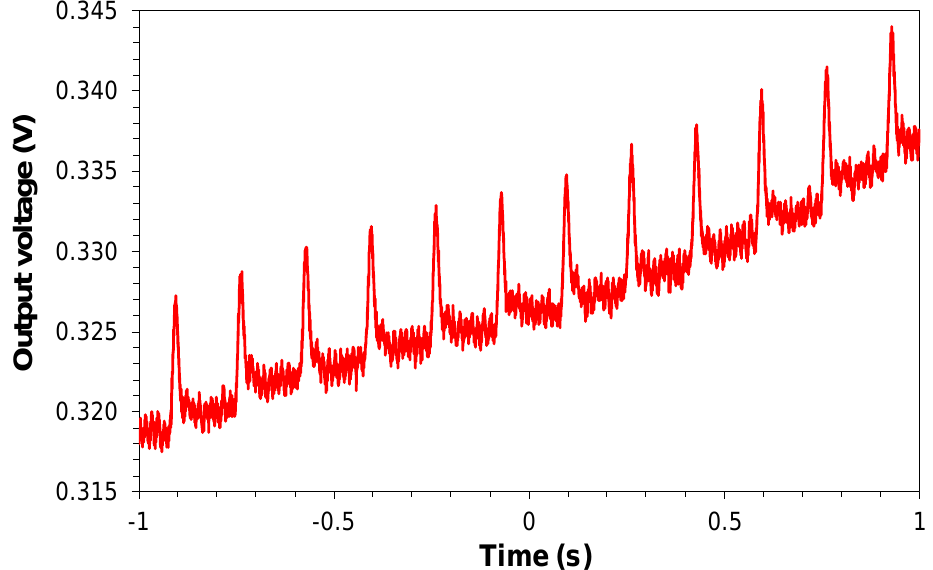
Figure 11. PWM signal versus time of sensor #1 that was obtained during the temperature stabilization period at the engine monitoring point.